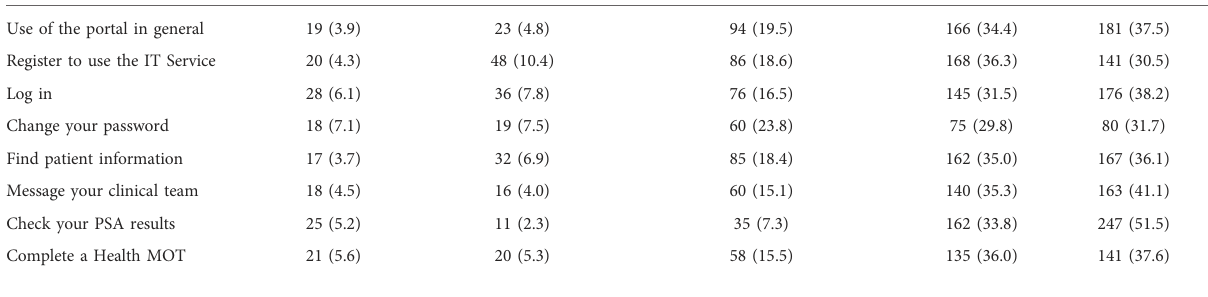
TABLE 4 Portal ease of